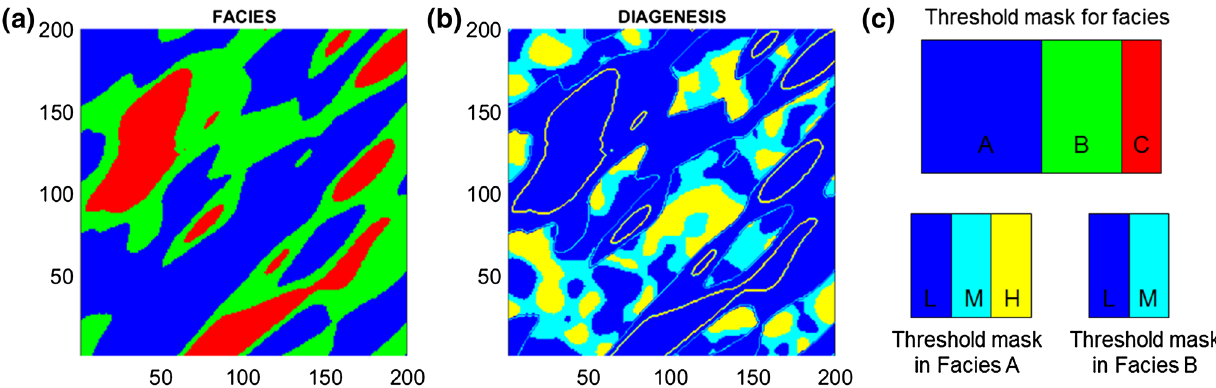
Fig. 3 Bi-TGS Application: a Realization with facies A , B and C ; b Realization with diagenetic levels L , M and H . The color lines indicate facies boundaries. c Threshold mask for facies and for diagenetic levels inside facies A and